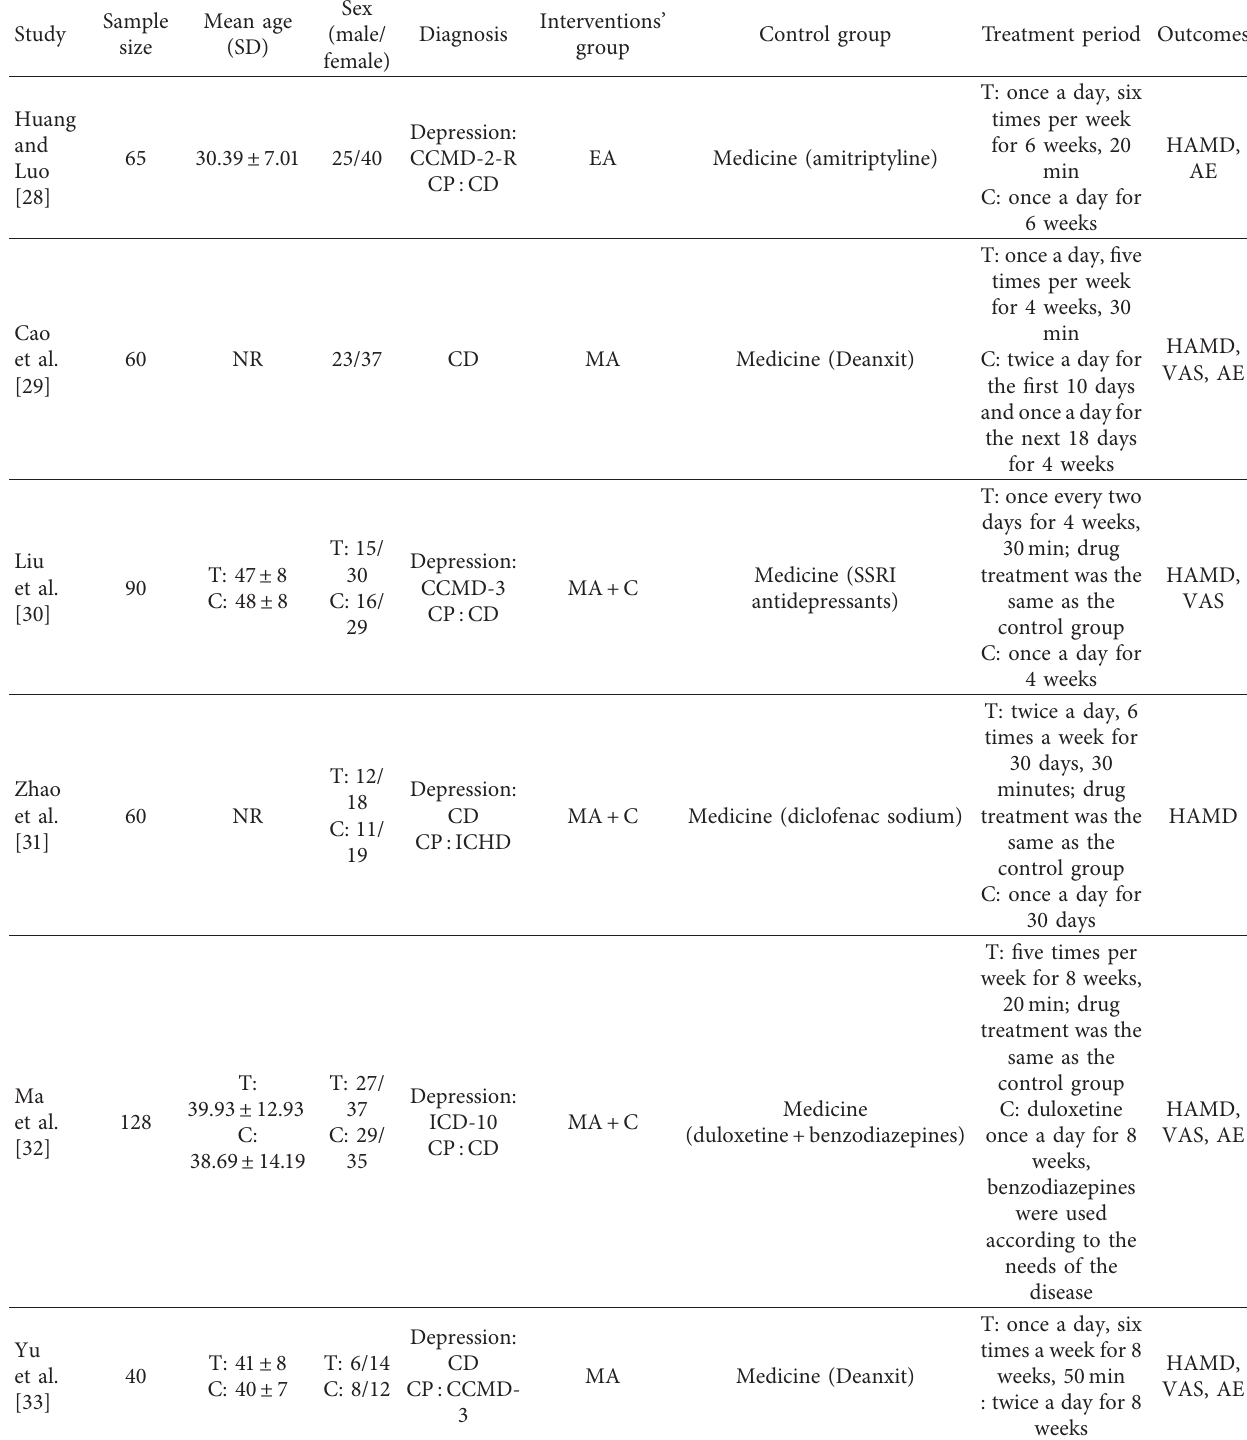
Table 1: Characteristics of included